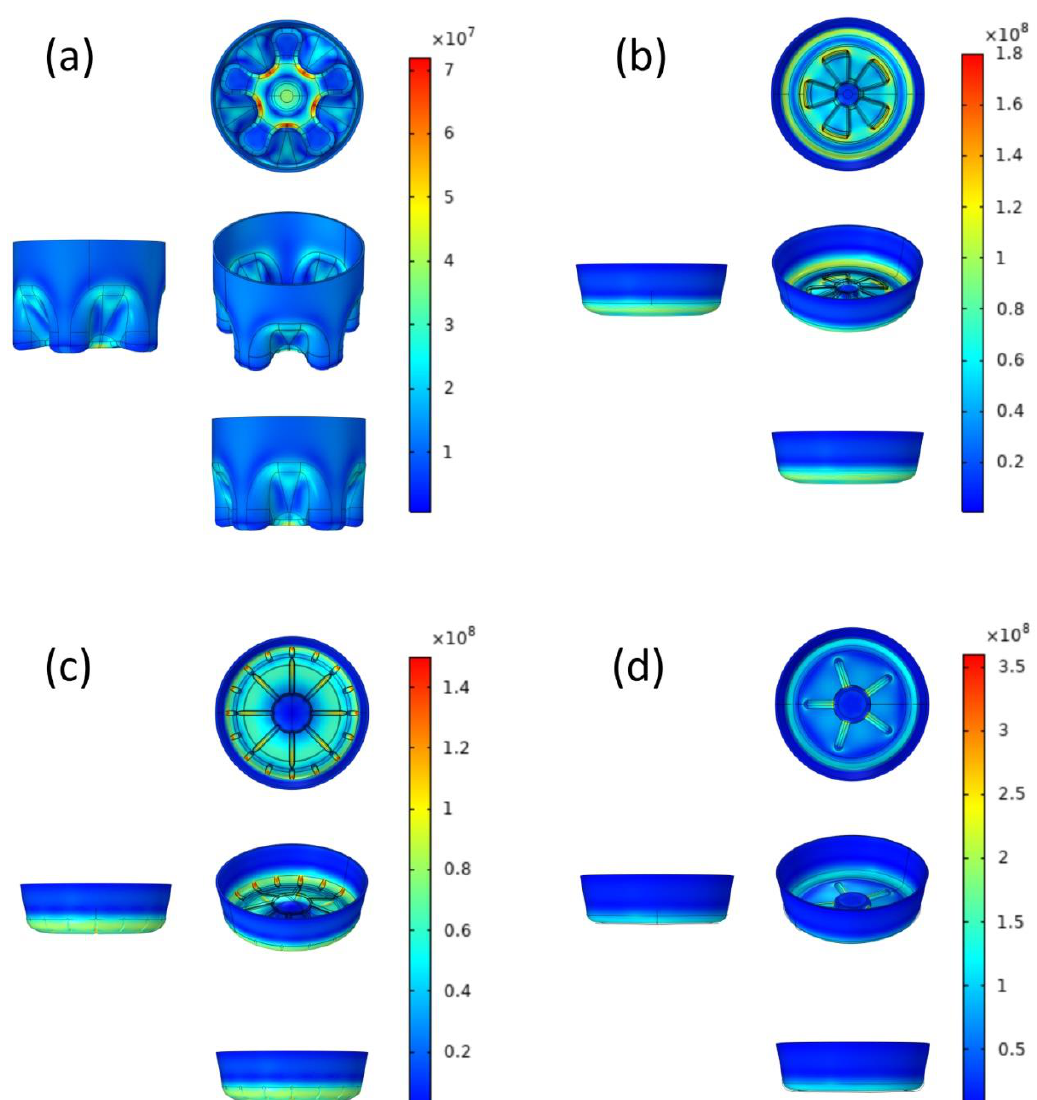
Figure 2. The Von Mises stress (Pa) surface distribution of pre-optimized models CF-bottom ( a ), PP-bottom ( b ), PR-bottom ( c ), and OR-bottom ( d ).